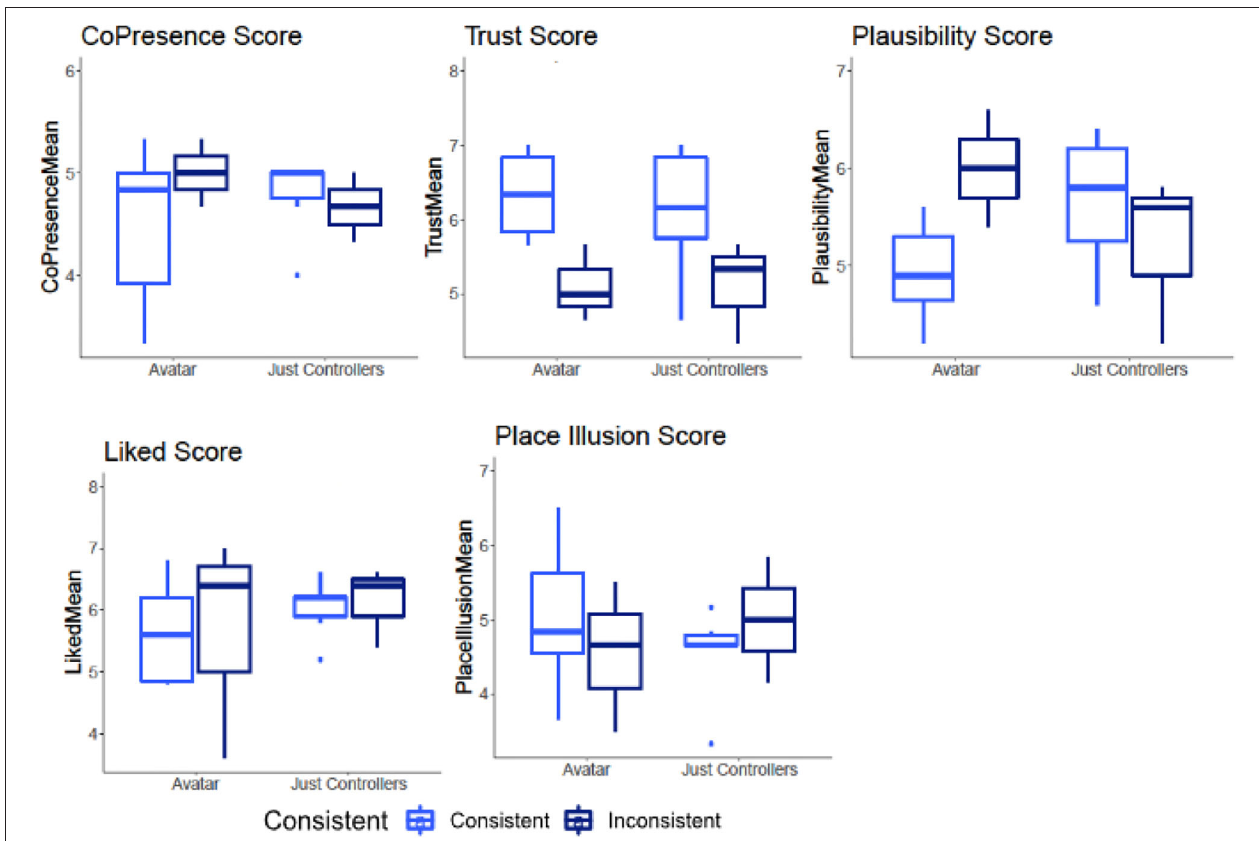
FIGURE 8 | Study 2: boxplots of social presence questionnaire components.